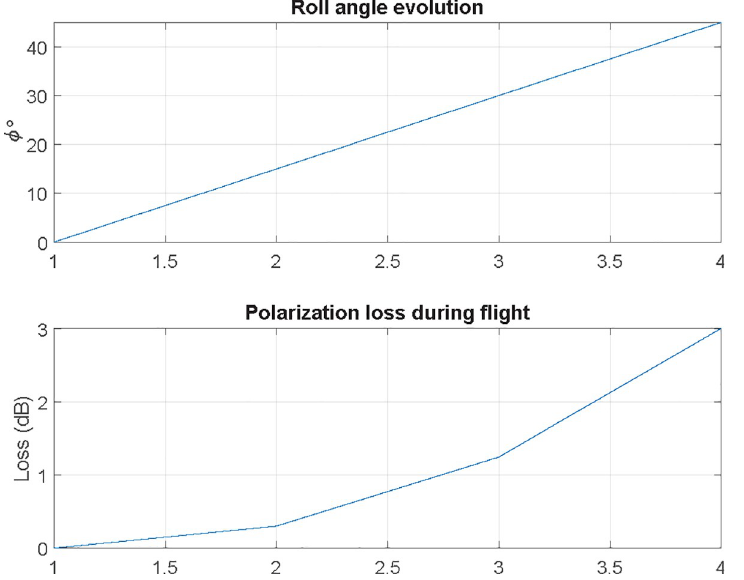
Fig 13. Roll angle evolution and decoupling losses due to rotation with respect to the x